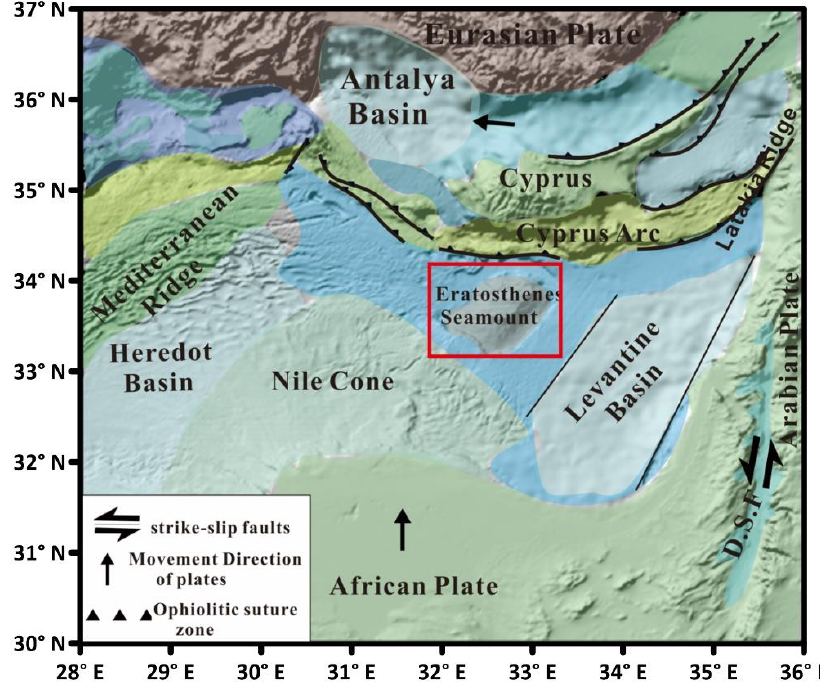
Figure 1. Major tectonic elements of Eastern Mediterranean and the location of the Eratosthenes Seamount, modified from Sage and Letouzey [25].